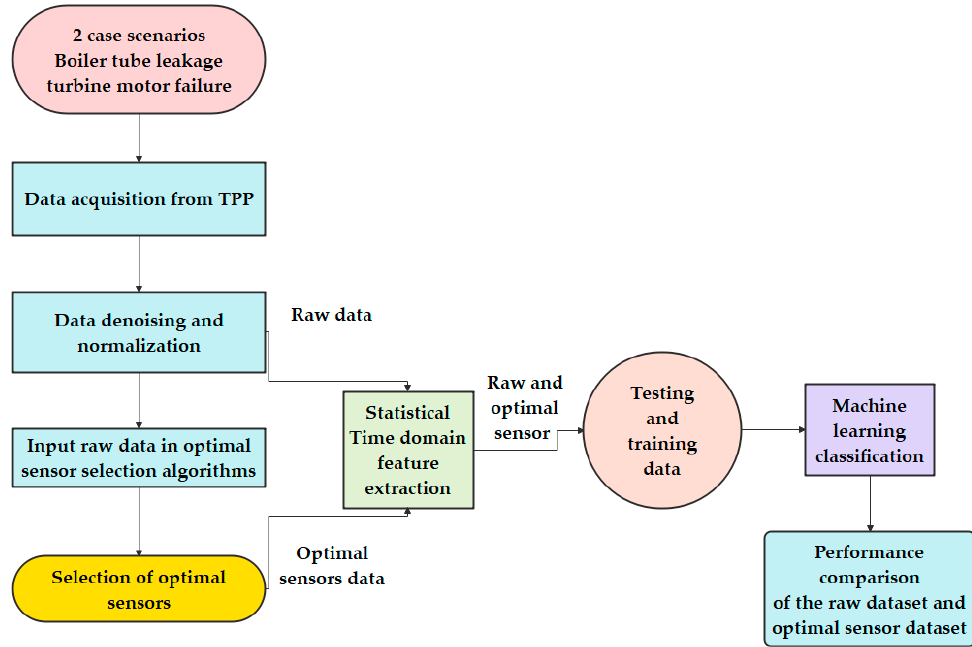
Figure 3. Schematic of the overall methodology.